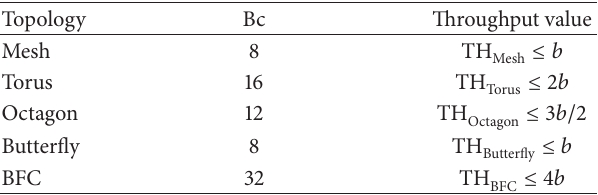
Figure 10: Expanded BFC network coupled with Mesh structure. Table 1: Comparison of ideal